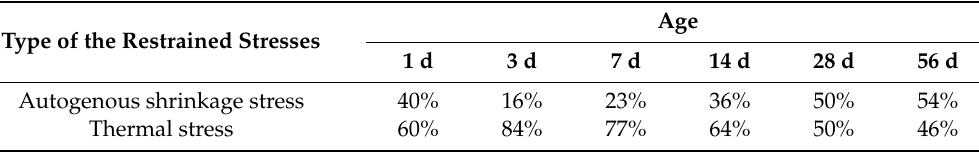
Figure 8. The development of the autogenous shrinkage stress, thermal stress and the total restrained stress under U-streel restraint and sealed condition. Table 5. The proportions of autogenous shrinkage stress and thermal stress in total restrained stress under U-streel restraint and sealed condition.